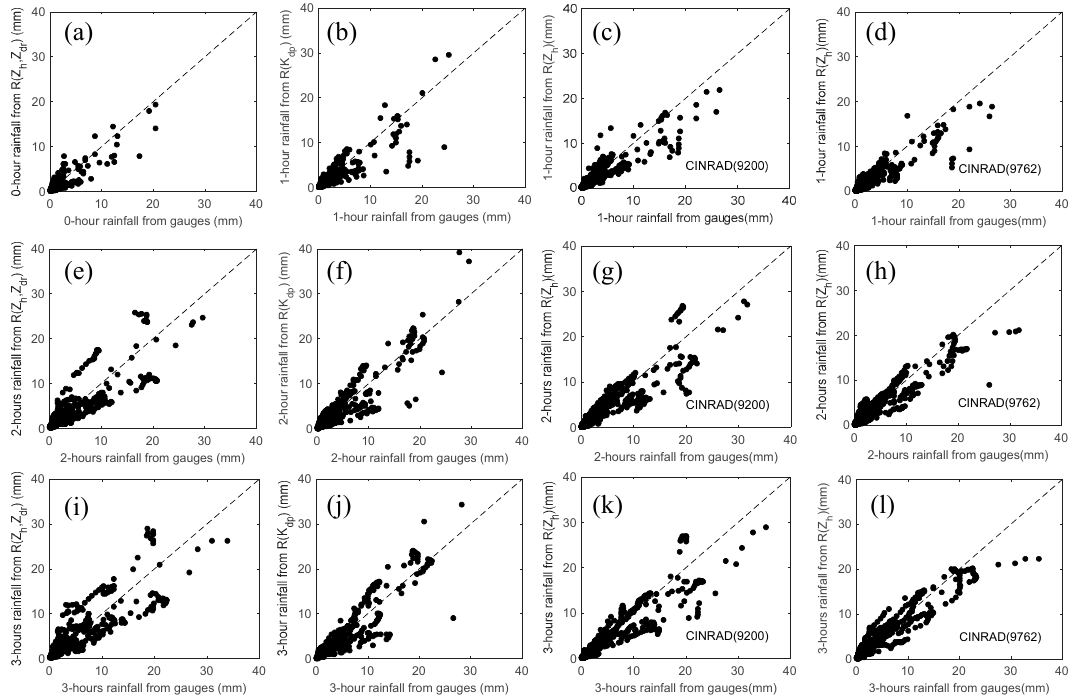
Figure 11. Scatterplots of radar rainfall estimate versus rain gauge for all events. ( a ) 1-h ( e ) 2-h ( i ) 3-h of R ( Z h , Z dr )-based rainfall accumulations for XPRAD; ( b ) 1-h ( f ) 2-h ( j ) 3-h of R ( K dp )-based rainfall accumulations for XPRAD; ( c ) 1-h ( g ) 2-h ( k ) 3-h of R ( Z h )-based rainfall accumulations for CINRAD(9200); ( d ) 1-h ( h ) 2-h ( l ) 3-h of R ( Z h )-based rainfall accumulations for